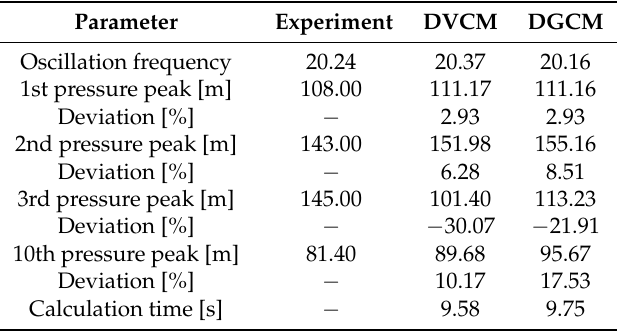
Figure 8. Comparison of the experimental data of experiment 4 [41] with the simulated results obtained with the Discrete Vapour Cavity Model (DVCM) and the Discrete Gas Cavity Model (DGCM). Table 5. Comparison of the Discrete Vapour Cavity Model (DVCM), the Discrete Gas Cavity Model (DGCM), and experimental results for experiment 4